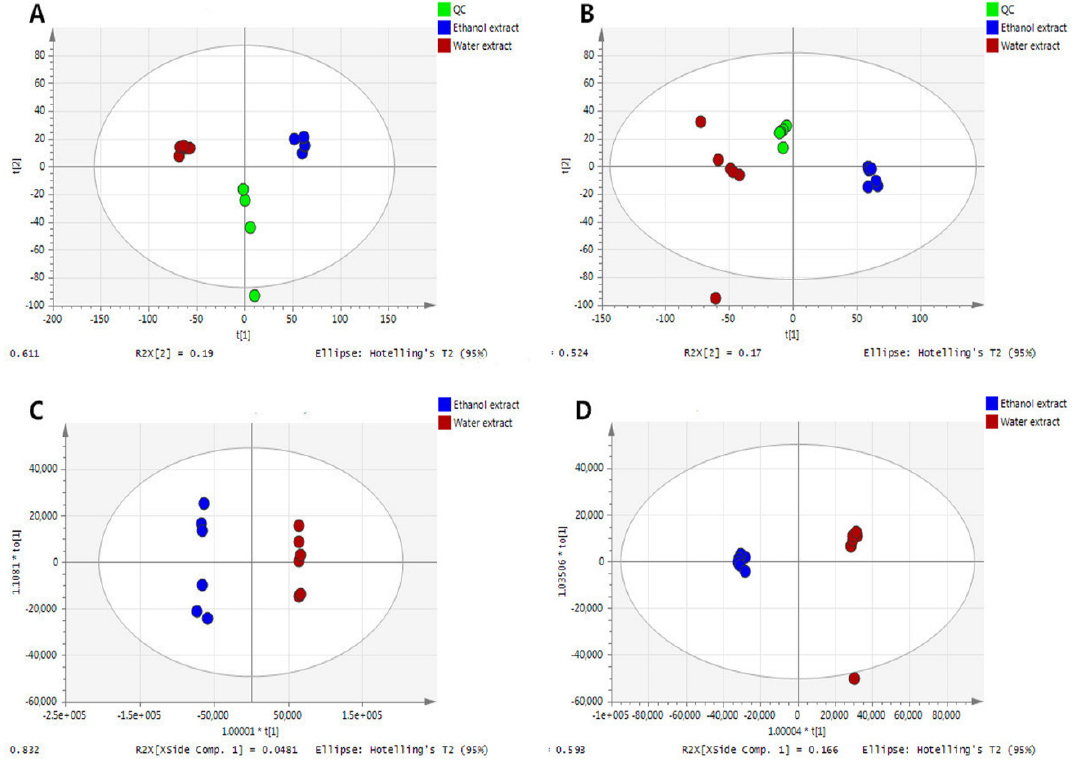
Figure 2. Partial Least Squares Discriminant Analysis (PLS-DA) diagram of CDAE and CDEE. ( A ) Positive ions (PCA); ( B ) Negative ions (PCA); ( C ) Positive ions (PLS-DA); ( D ) Negative ions (PLS-DA).